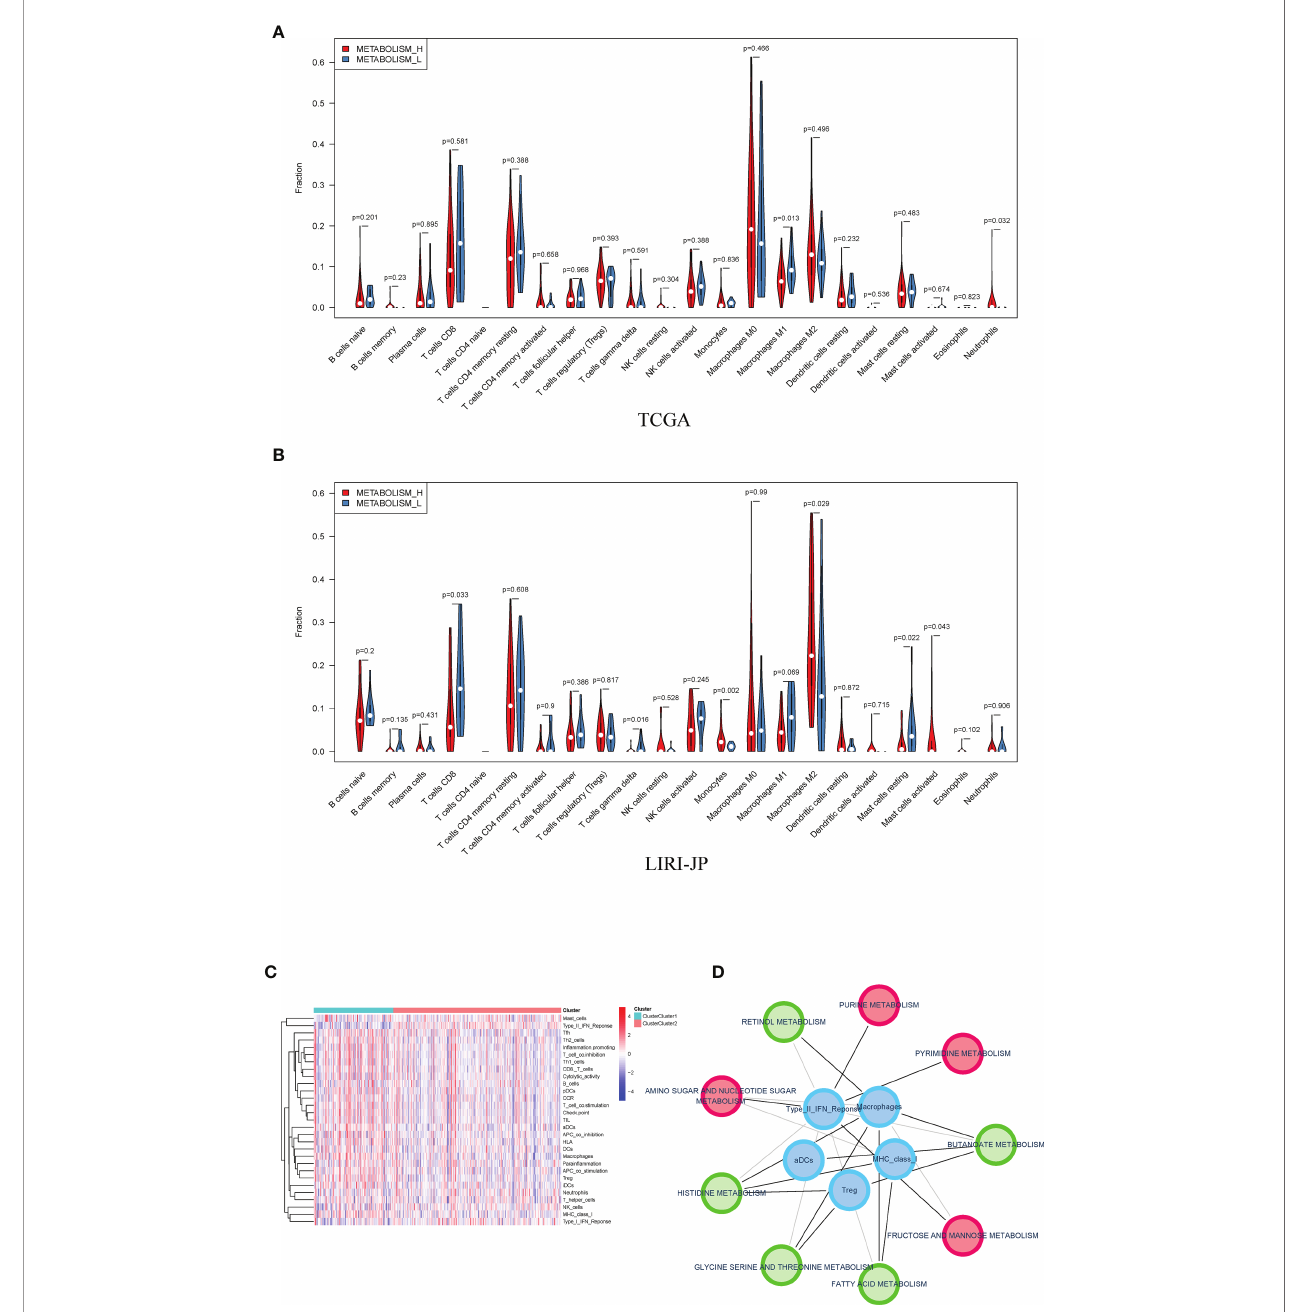
FIGURE 5 | Distribution of immune cells in Metabolism_H and Metabolism_L. (A) In TCGA, Metabolism_L contained more naive B cells, gamma delta T cells, and resting mast cells (Wilcoxon test), the same as in (B) LIRI − JP. (C) A heatmap showed that different clusters led to signi fi cantly different gene expressions in immune pathways. (D) A metabolism-related pathways – immune-related pathways network indicated that metabolic pathways were associated with tumor